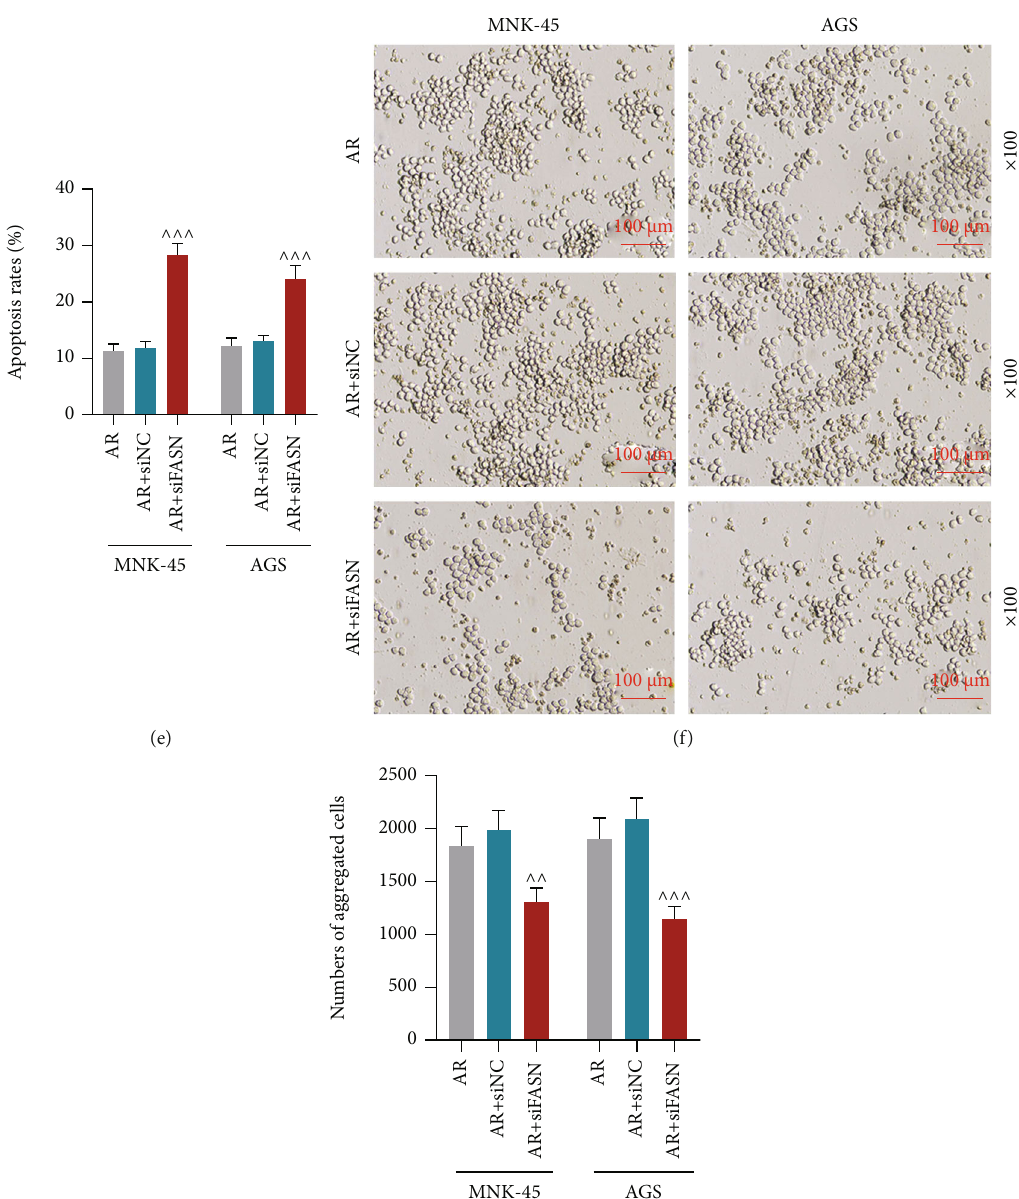
Figure 3: Small interfering RNA targeting fatty acid synthase (siFASN) promoted apoptosis while suppressing cell aggregation and FASN expression. (a) Relative fatty acid synthase (FASN) mRNA expression levels in MNK-45 and AGS cells in the anoikis resistance (AR), AR+ small interfering RNA negative control (siNC), and AR + siFASN groups were evaluated by quantitative reverse transcription-polymerase chain reaction (qRT-PCR). (b) Representative pictures of relative FASN protein expression levels in MNK-45 and AGS cells in the AR, AR +siNC, and AR + siFASN groups during western blot. β -Actin was used as a loading control. (c) Relative FASN protein expression levels in MNK-45 and AGS cells in the AR, AR +siNC, and AR + siFASN groups were assessed by western blot. (d) Cell apoptosis was evaluated using a fl ow cytometer and an Annexin-V-FITC Apoptosis Detection Kit with PI. (e) Quantitation of the apoptosis rates of MNK-45 and AGS cells in the AR, AR +siNC, AR +siFASN groups determined through cell apoptosis assay. (f) Pictures of the morphology of MNK-45 and AGS cells in the AR, AR +siNC, and AR +siFASN groups were taken under a microscope during suspension culture. (g) Numbers of aggregated MNK-45 and AGS cells in the AR, AR +siNC, and AR +siFASN groups were manually counted by microscopy. ^^ p < 0.01 vs. AR +siNC group; ^^^ p < 0.001 vs. AR +siNC group. Data were performed as the means ±